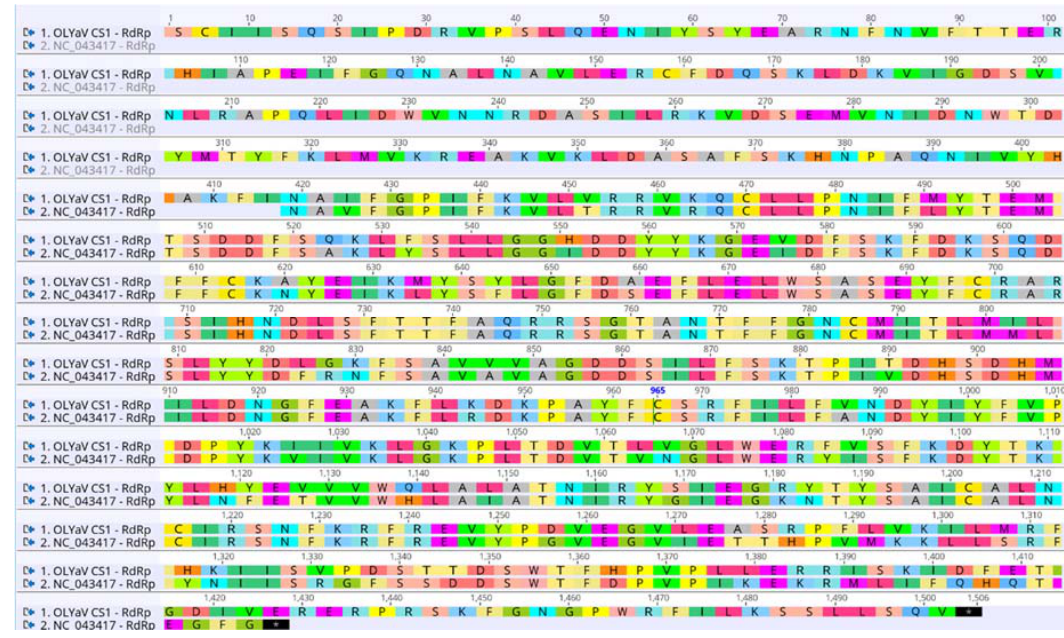
Figure 4. Amino acid alignment between the RdRp of OLYaV-CS1 and the RdRp of OLYaV NC_043417 isolates revealing a larger protein in the OLYaV-CS1 isolate. The numbers indicate the nucleotide position from the beginning of the ORF1b in the OLYaV CS1 isolate.